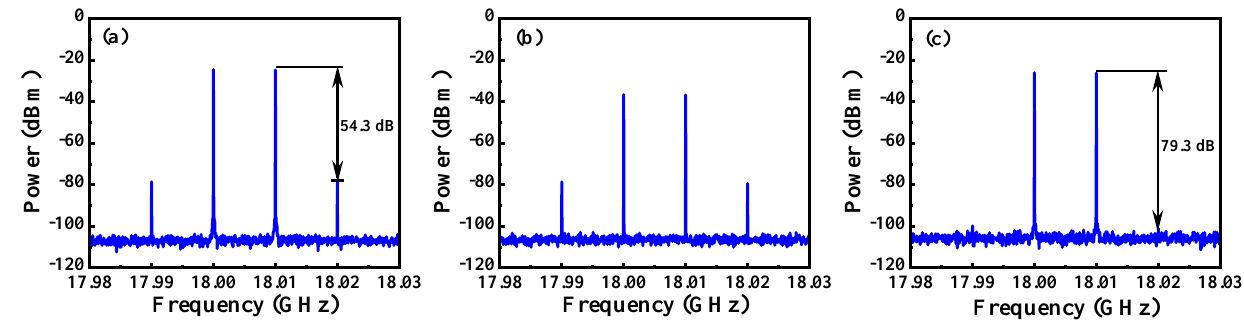
Figure 4. The frequency up-conversion electrical spectrum of ( a ) upper path, ( b ) lower path and ( c ) combination output from BPD (RBW = 10 kHz).